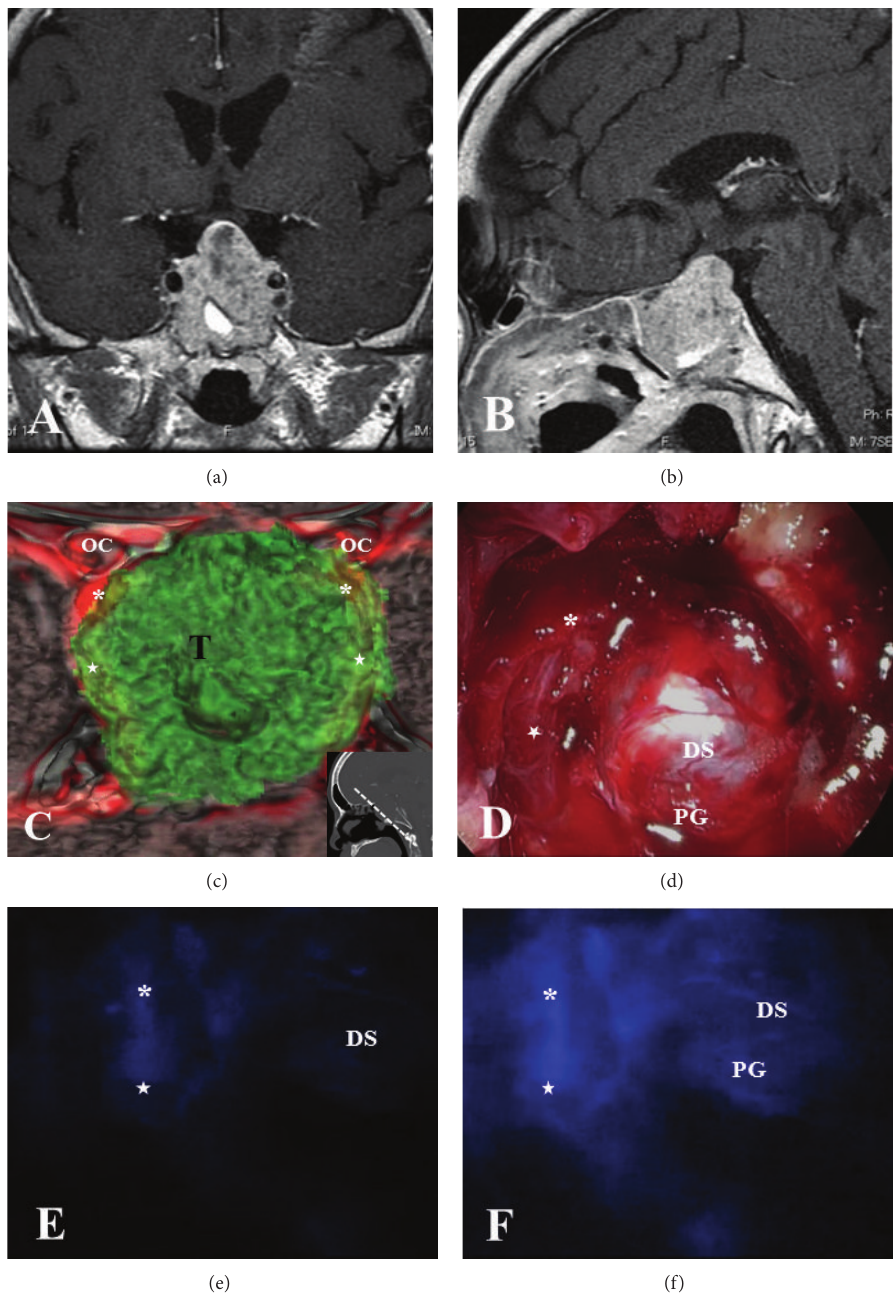
Figure 4: Preoperative image of a fusion model of 3D-CT and MRI and intraoperative endoscopic view and ICG fluorescence views in Case 3 . (a, b) Preoperative coronal and sagittal Gd-enhanced MRI in Case 3 showing a pituitary tumor extending into the sphenoidal sinus with involvement of both ICAs by the tumor. (c) Preoperative 3D-CT and MRI fusion model revealing the relationship between the tumor and the vital structures such as the ICAs and optic nerves and the location of the ICAs (asterisks: C3; stars: C4) by eliminating bony structures. (d) Endoscopic view after decompression of the tumor showing residual tumor bilaterally with descending diaphragma sellae (DS) centrally. (e, f) ICG endoscopic views visualizing the right ICA (asterisk: C3; star: C4) under the tumor and the normal pituitary gland (PG) at the posterior part of the diaphragma sellae. T: